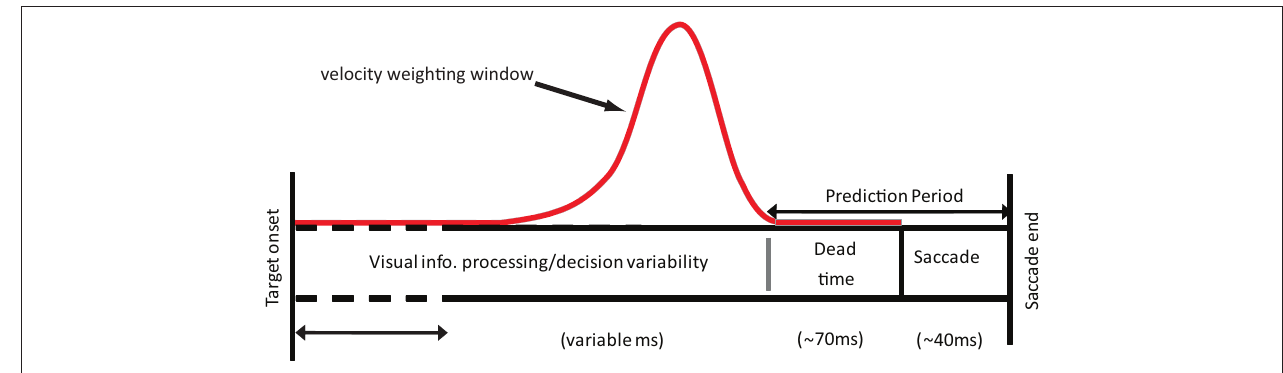
Figure 1 | The time course of a saccade from target detection to the end of the saccade. During this time, average velocity is estimated using a weighting window similar in nature to the one shown here (red solid line). The target is assumed to move at this averaged velocity during the prediction period. This information can then be used to determine where the target is likely to be located at the end of